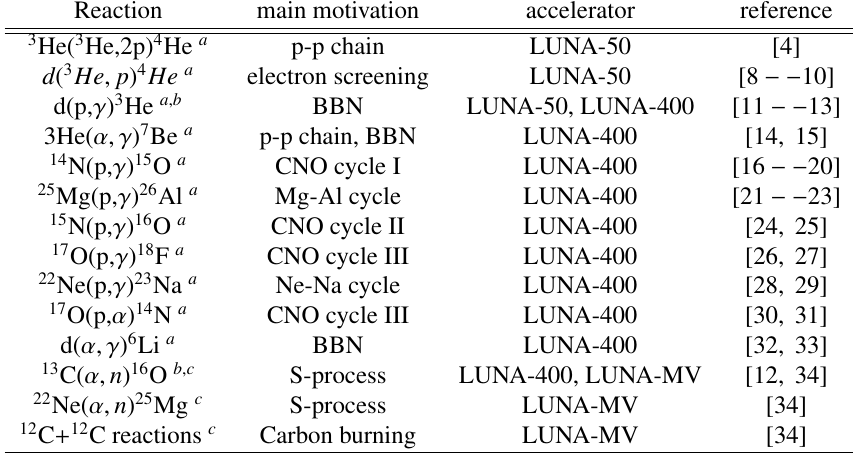
Table 1. Selection of nuclear reaction already studied by LUNA (a), in progress (b) and in program